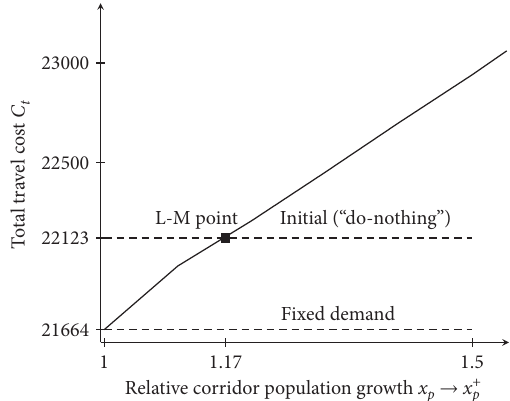
Figure 5: Travel costs C t against corridor population growth.